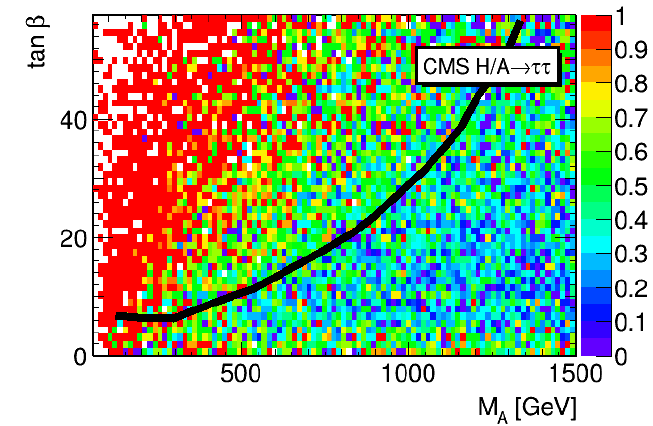
Figure 12 . Fraction of points excluded by direct detection constraints in the ( M A ; tan (cid:12) ) parameter plane. The CMS 13 TeV exclusion line from H=A ! (cid:28)(cid:28) searches [170] is also plotted for comparison. cluded in a triangle region starting from the origin of the plot and up to tan (cid:12) = 60 and M = 600 GeV. A large fraction of the points with larger M A comparison, the exclusion line from the CMS heavy Higgs searches for H=A ! (cid:28)(cid:28) is